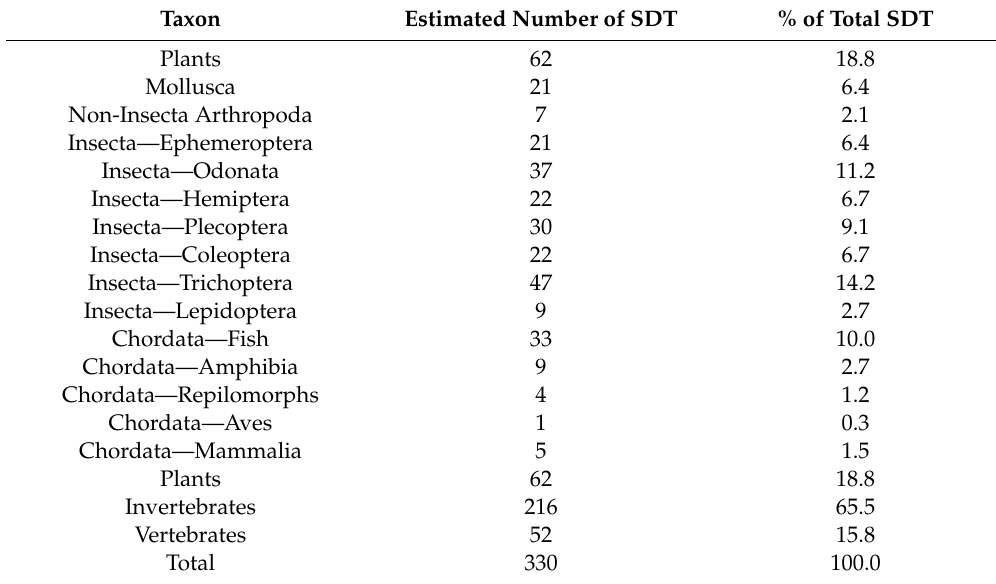
Table 2. Estimated and known springs-dependent taxa in the Colorado River basin. Estimates of Ephemeroptera, Plecoptera, and Trichoptera springs-dependent taxa (SDT) richness are based on the percent of known species with restricted elevation ranges.